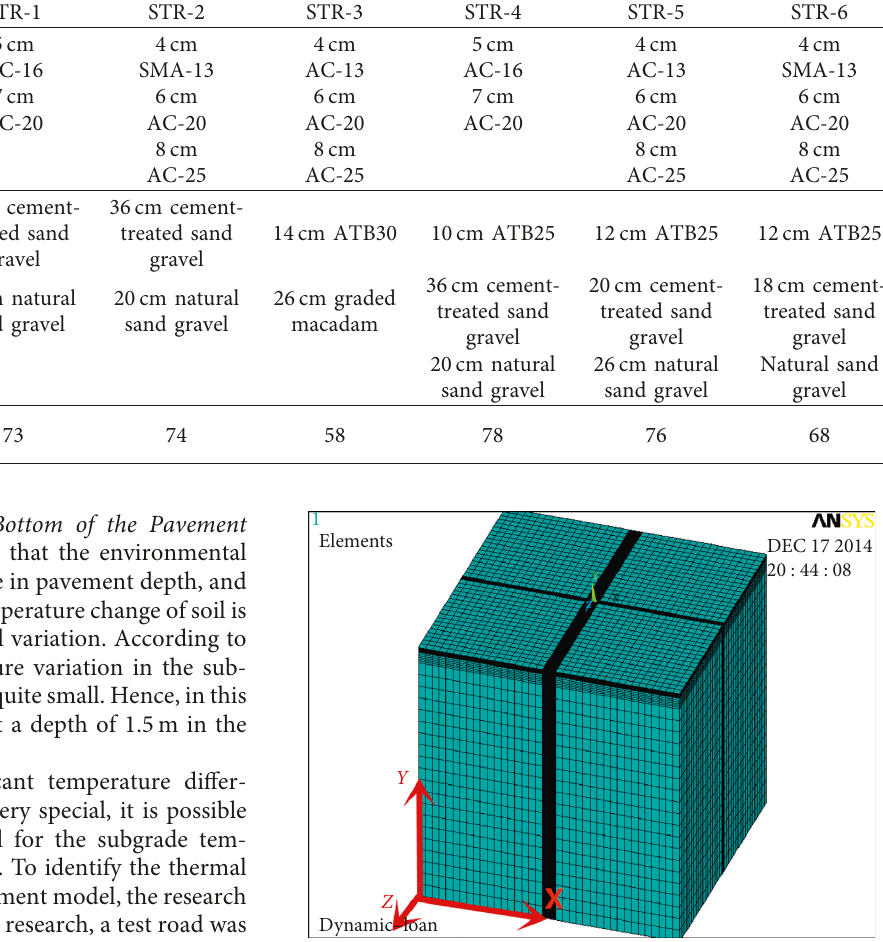
Table 2: Pavement structures selected in this study.